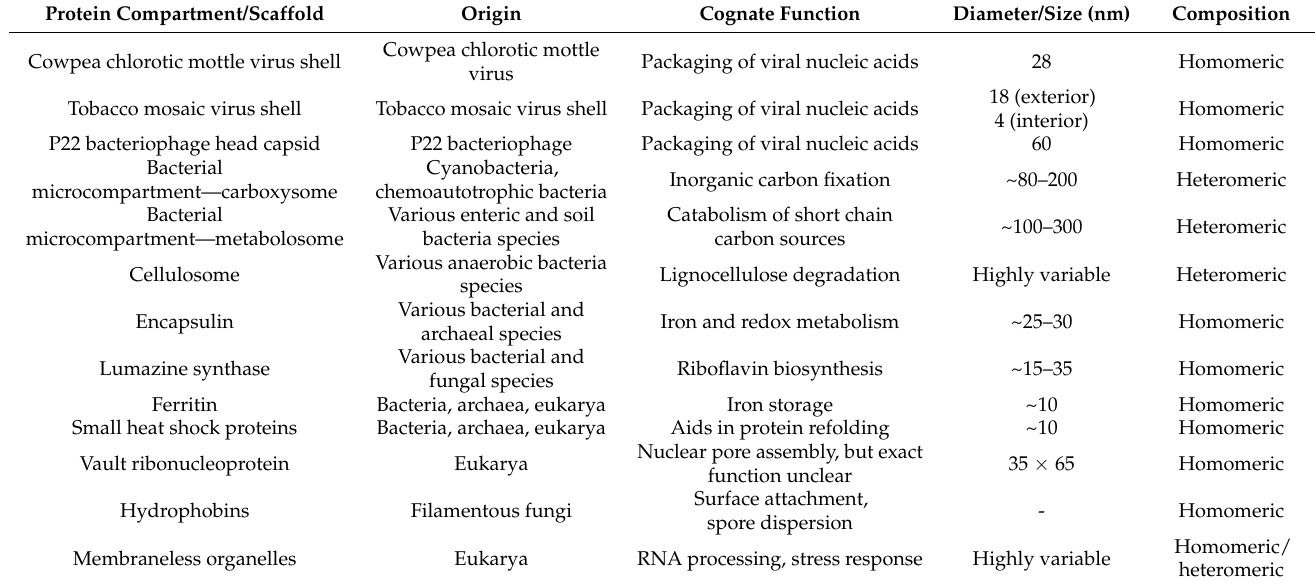
Bacteria, archaea,